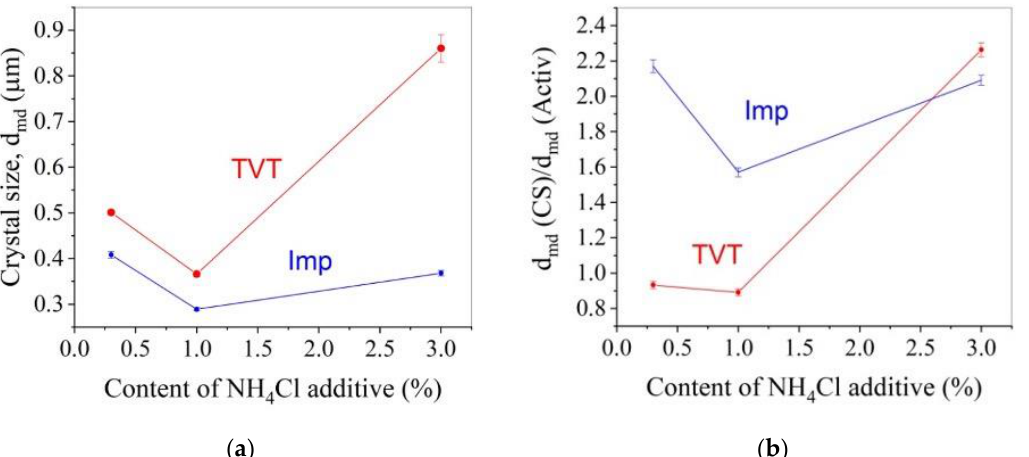
Figure 10. Dependence of average grain size ( a ) and relative change in average crystal size ( b ) of CS samples on concentration of AmCl additive and method of ZnO powder activation: red line, circles - TVT method (indicated as TVT); blue line, squares - impregnation method (indicated as Imp).